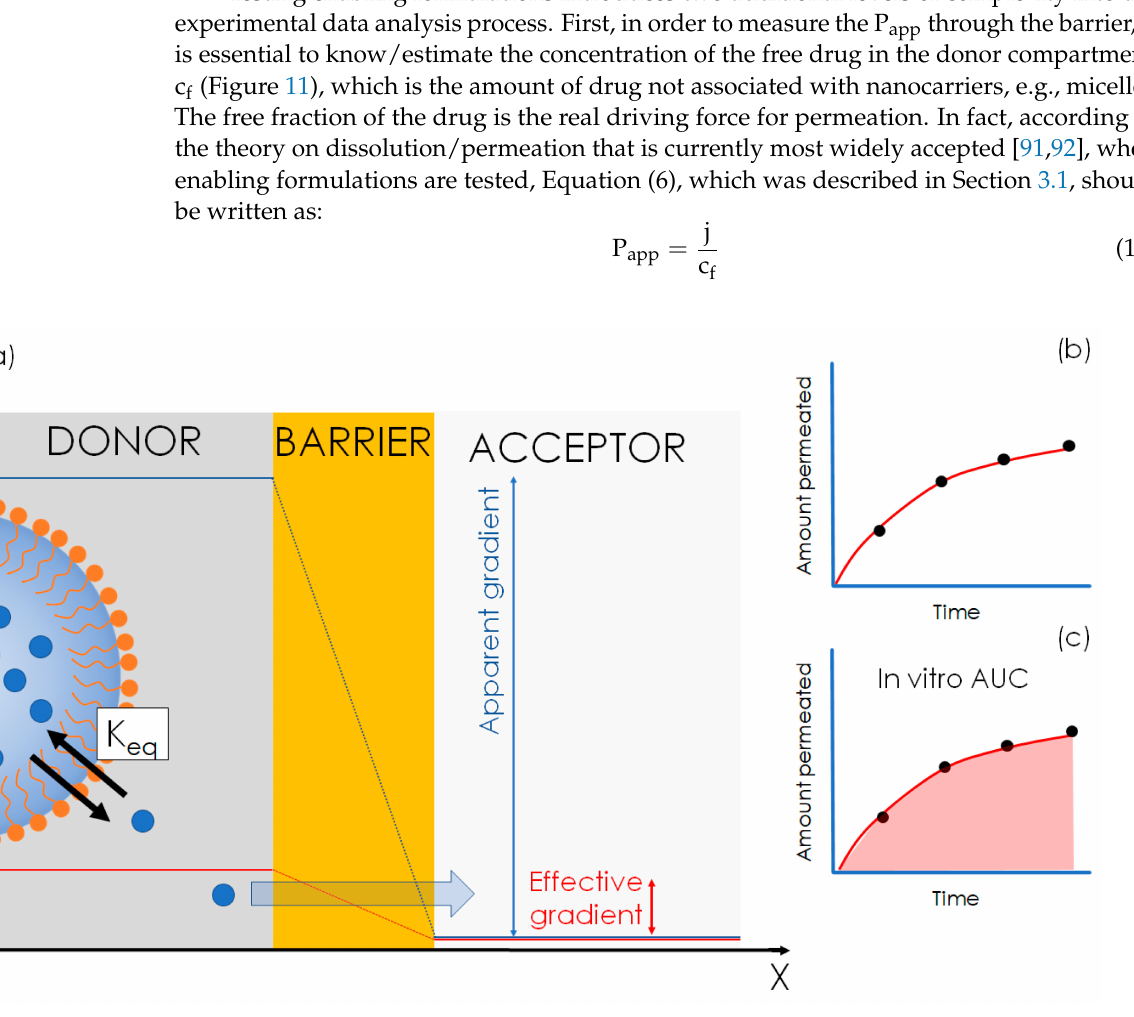
Figure 11. Simplified permeability model for a nanocarrier-based enabling formulation ( a ) and the corresponding mass transfer profile ( b ) and the in vitro AUC ( c ). According to the free-fraction theory [93], the effective gradient for permeation should be given by the free drug fraction, c f , i.e., the unloaded drug. The mass flux profile in this case is highly influenced by the equilibrium constant (K eq ) of the loaded (in the nanocarrier) to the unloaded (free)